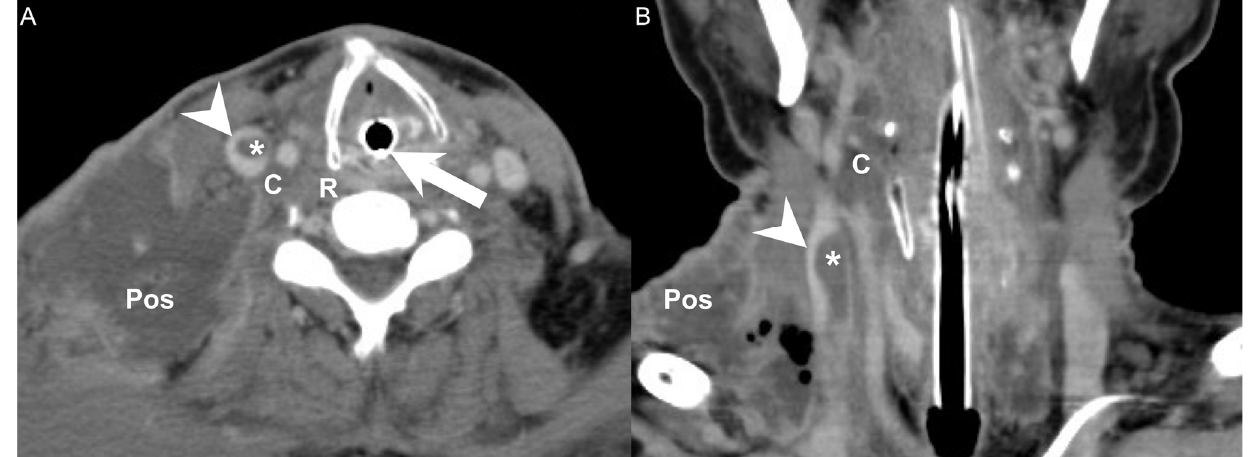
Figure 1. ( A ) CT axial view and ( B ) coronal view of a patient with concurrent DNI and LS. Arrowhead: internal jugular vein; Asterisk: thrombosis; Arrow: endotracheal tube; C: carotid space; Pos: posterior cervical space; R: retropharyngeal space.